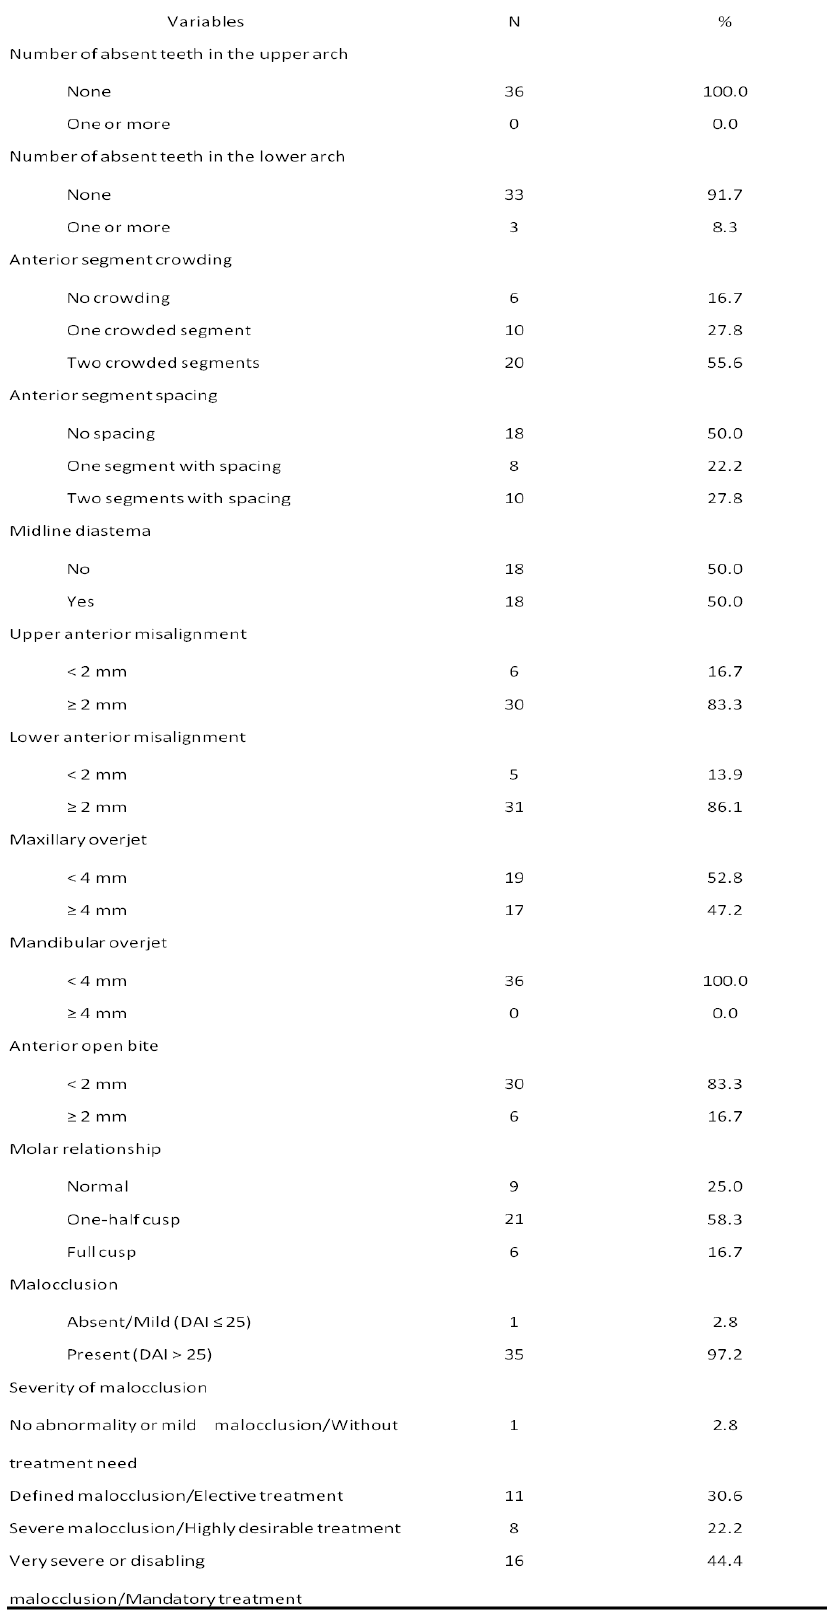
Table 2. Prevalence of malocclusions and components assessed by the Dental Aesthetic Index (DAI) among Quilombola